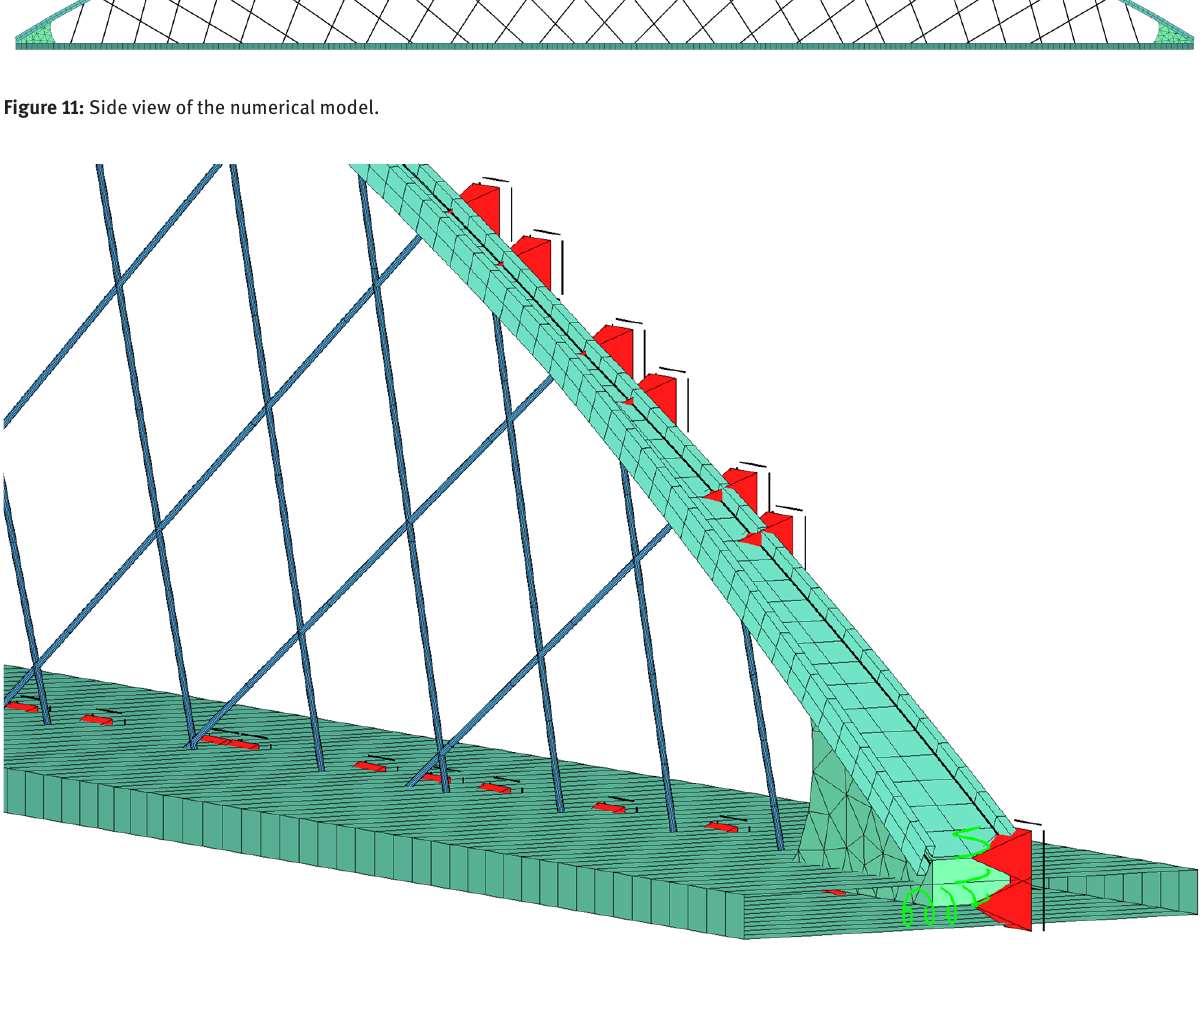
Figure 12: Detail view of the skewback.